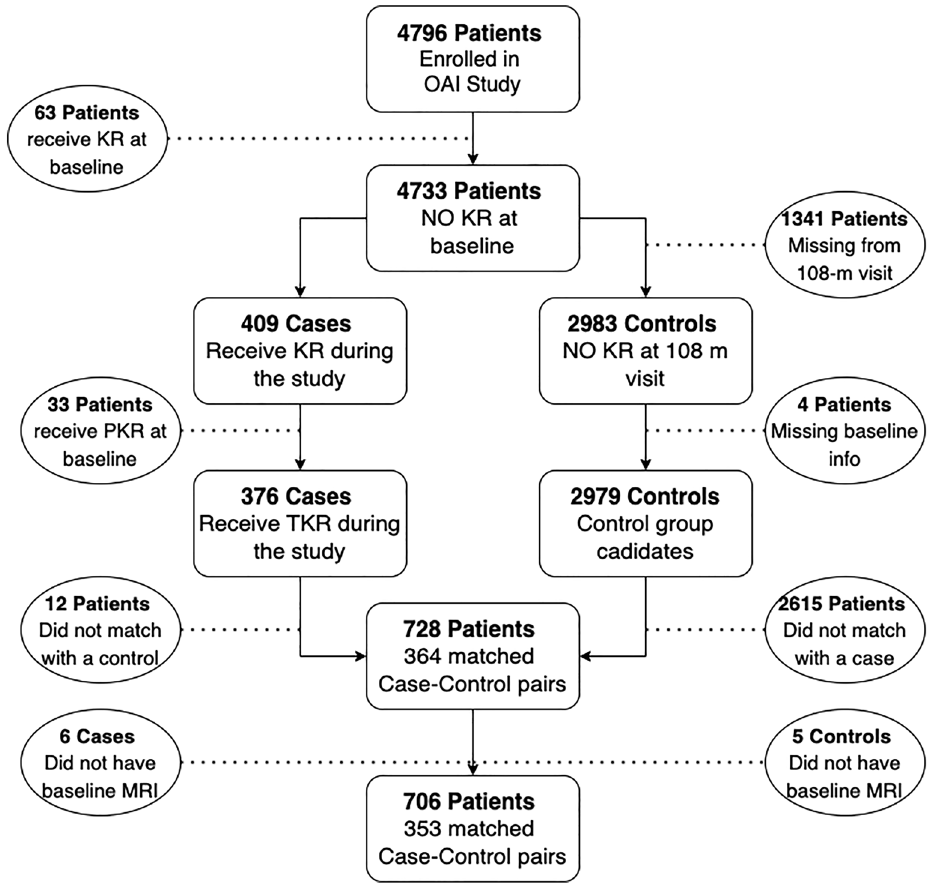
Figure 1. Selection of the 353 case–control pairs of subjects in the OAI database with and without TKR over a 108-month follow-up period that comprised the subject